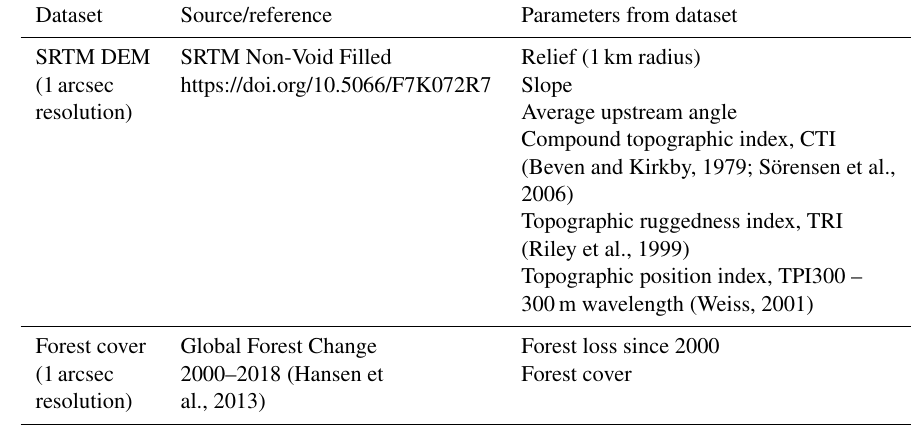
Table 3. Analysis datasets. Explanation of each of the variables is found in the accompanying